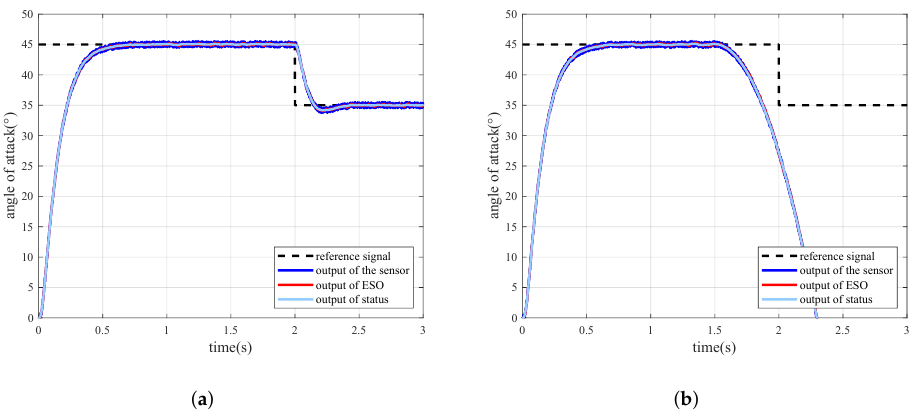
Figure 7. ( a ) Angle of attack under the gain variation fault; ( b ) angle of attack under the stuck fault.